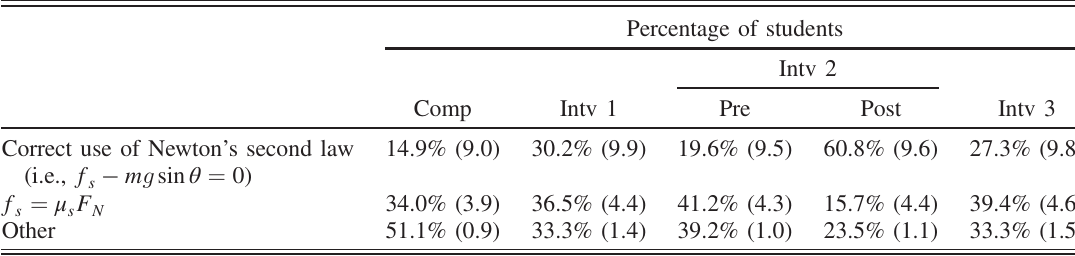
TABLE VI. Percentage of students in each group who used particular problem-solving approaches in the algebra- based course. The average score obtained by students in each group is also listed in the parentheses for